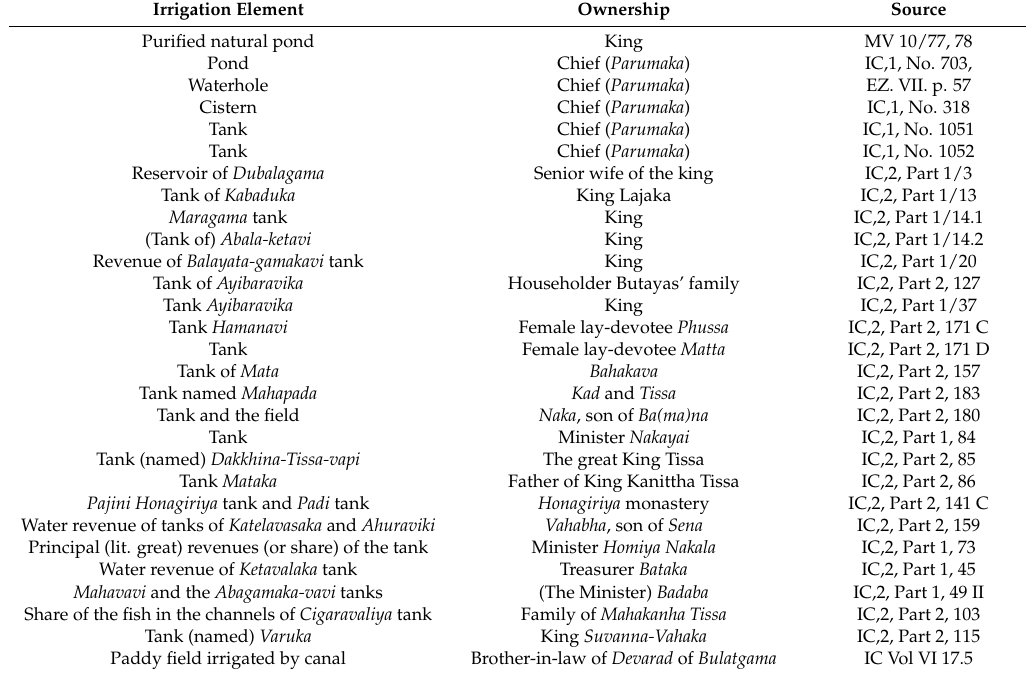
Table 3. Ownership of irrigation mentioned in ancient